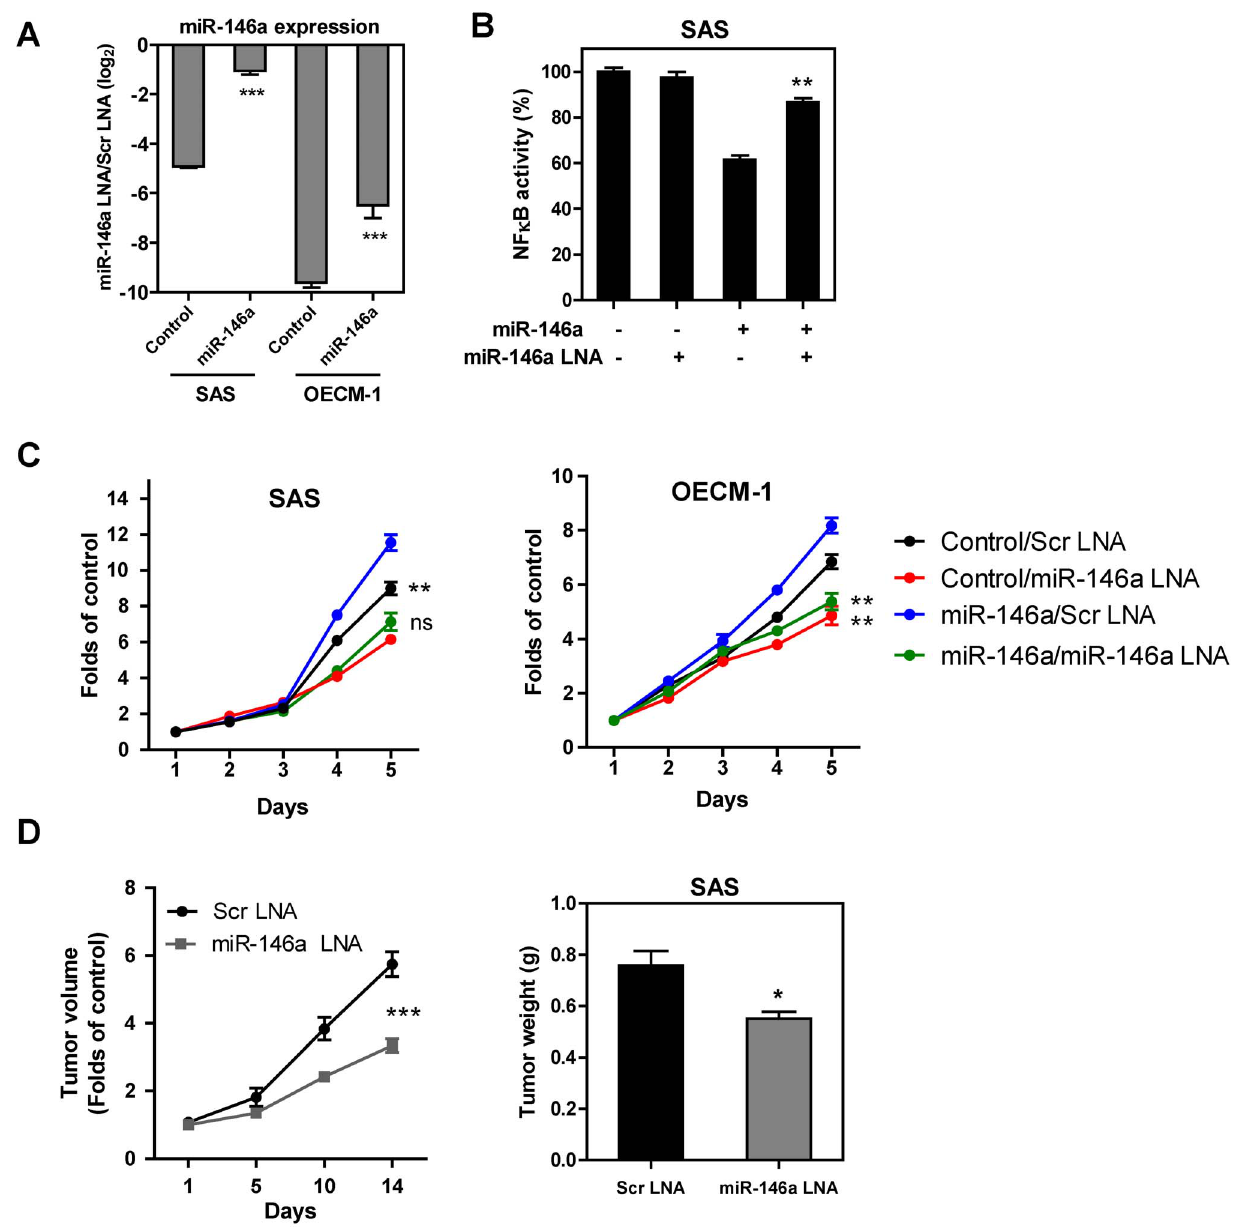
Figure 6. miR-146a LNA treatment inhibits OSCC oncogenicity. (A) qRT-PCR analysis. After treatment with miR-146a LNA, endogenous and exogenous miR-146a expression is reduced. (B) The miR-146a LNA treatment results in an increase in NF k B activity, which had been down-regulated by exogenous expression of miR-146a in the SAS cells. (C) miR-146a LNA treatment decreases the growth of SAS cells (Lt) and OECM-1 cells (Rt) with or without exogenous miR-146a expression. The folds are determined by normalization of cell numbers at different time points to the numbers of cell seeded. (D) miR-146a LNA represses the tumorigenesis of SAS cells. Lt, growth curve of xenografts. The folds are determined by normalization of tumor volume at different time points to the tumor volume at the time point receiving the injection of miR-146a LNA. Rt, quantification of the weight of resected tumors. Data shown are the means 6 SE from at least triplicate analysis or five mice. Scr, scramble. ns , not significant; *, p , 0.05; **, p , 0.01; ***, p , 0.001; Mann-Whitney test or Two-Way ANOVA